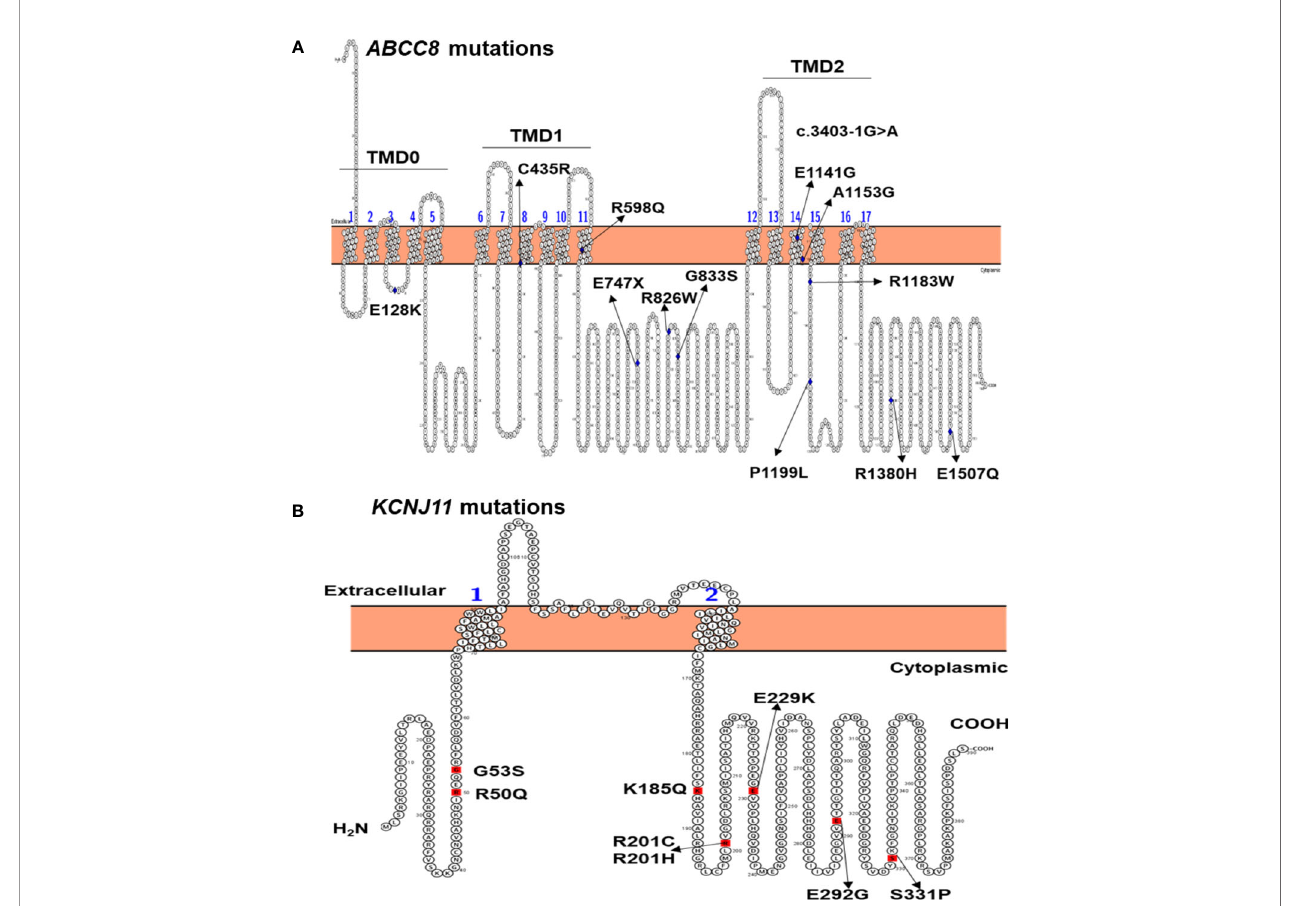
FIGURE 1 | Location of ABCC8 mutations in the SUR1 protein (A) and KCNJ11 mutations in the Kir6.2 protein (B) identi fi ed in 27 Vietnamese patients with NDM. TMD, transmembrane